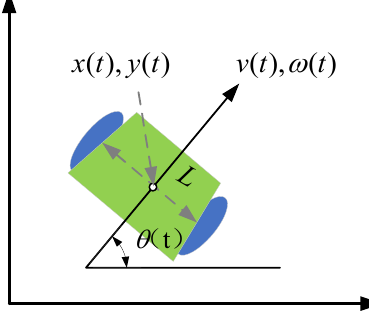
Figure 4. Robot kinematic